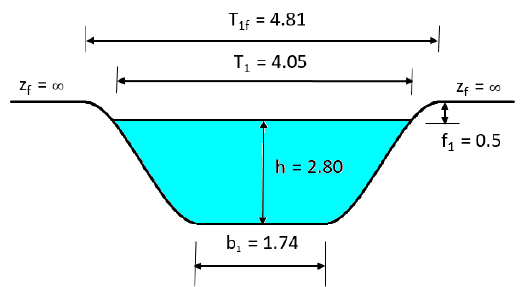
Figure 6. Optimal simple polynomial section with smooth top corners and horizontal slopes. at ground level ( z f = ∞ ; dimensions are in meters).